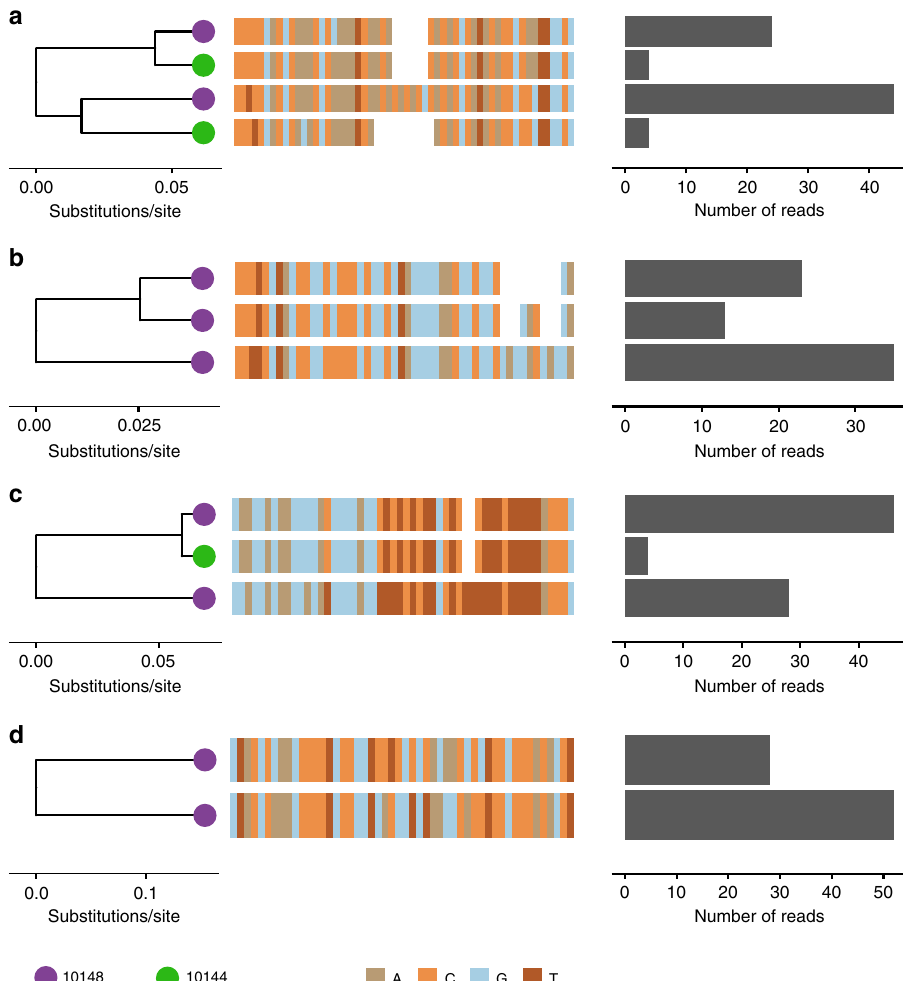
Fig. 5 Metagenomic sequence data reveal multi-strain DrBHV infections in individual bats. The phylogenies (left), nucleotide sequences (centre), and read count (right) of DrBHV strains present in the alignment of samples 10148_KF29 and 10144_KF29 (where read depth was suf fi cient for reads to be included) with the DrBHV consensus genome sequence. Nucleotide locations: ( a ) 47620 – 47671 (equivalent to part of Miniopterus schreibersii BHV B7D8 sample 10148_KF29. The tree tips are coloured by the individual bat from which the sequence